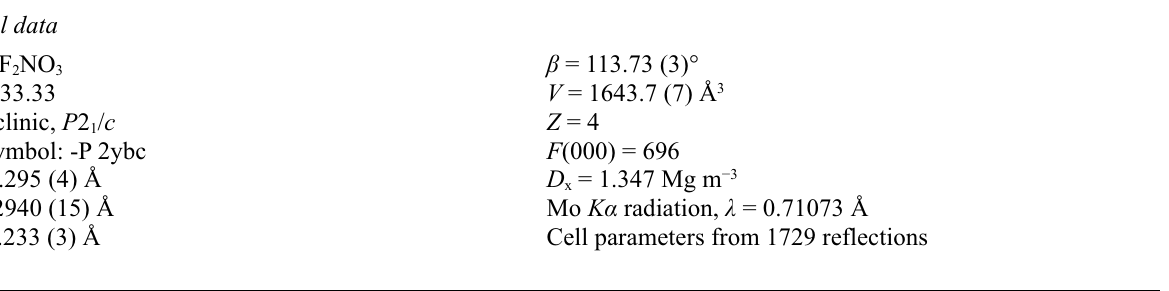
Figure 2 The crystal packing of the title compound. Dashed lines indicate C—H···O and C—H···pi hydrogen bonds. ( Z )-Ethyl